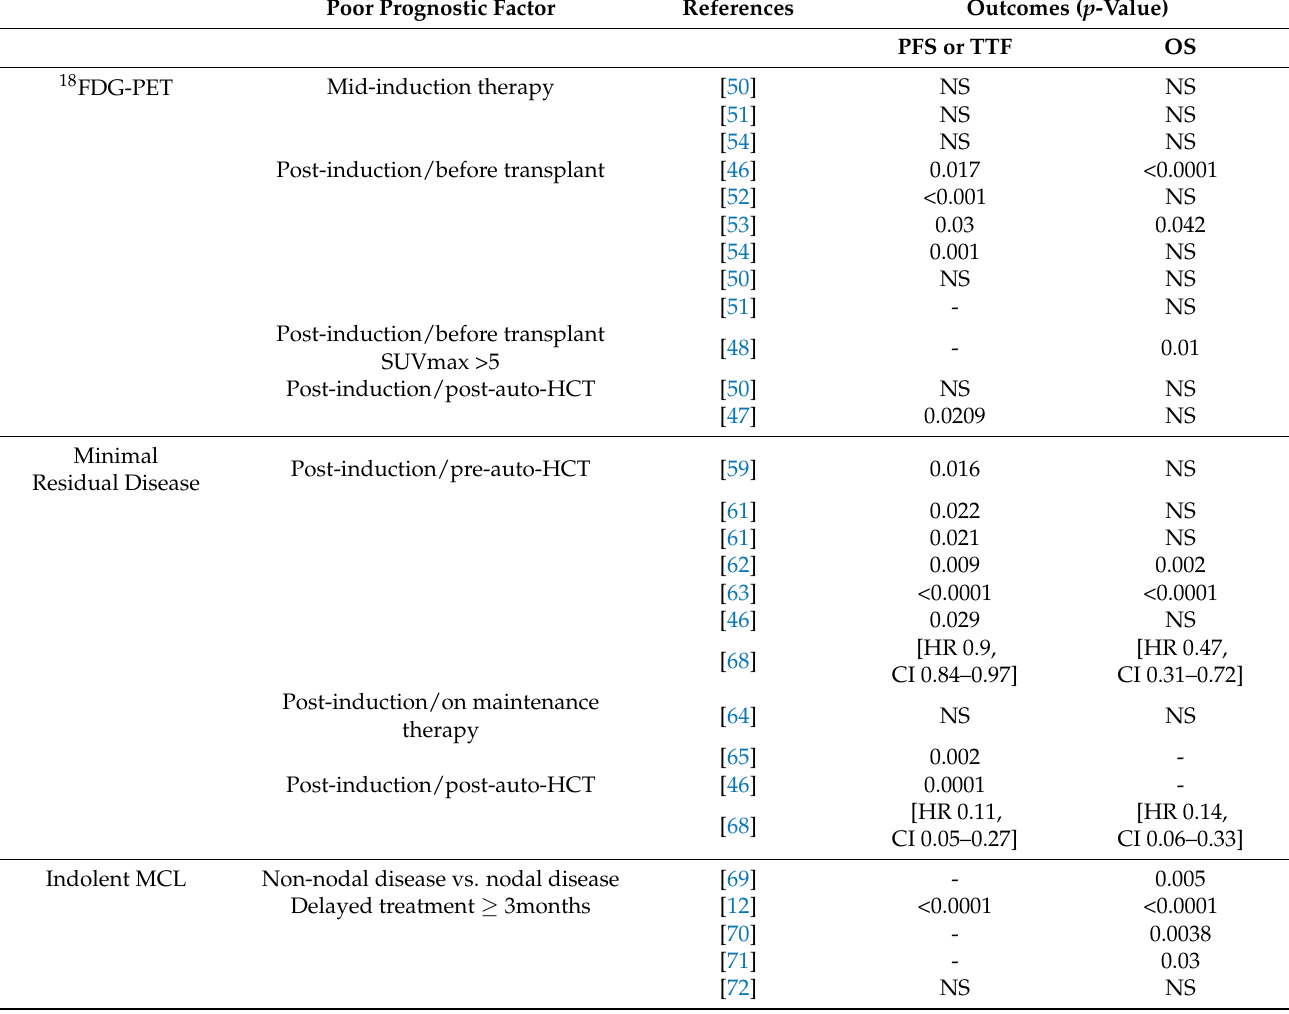
Table 2. Prognostic Factors Determined Following